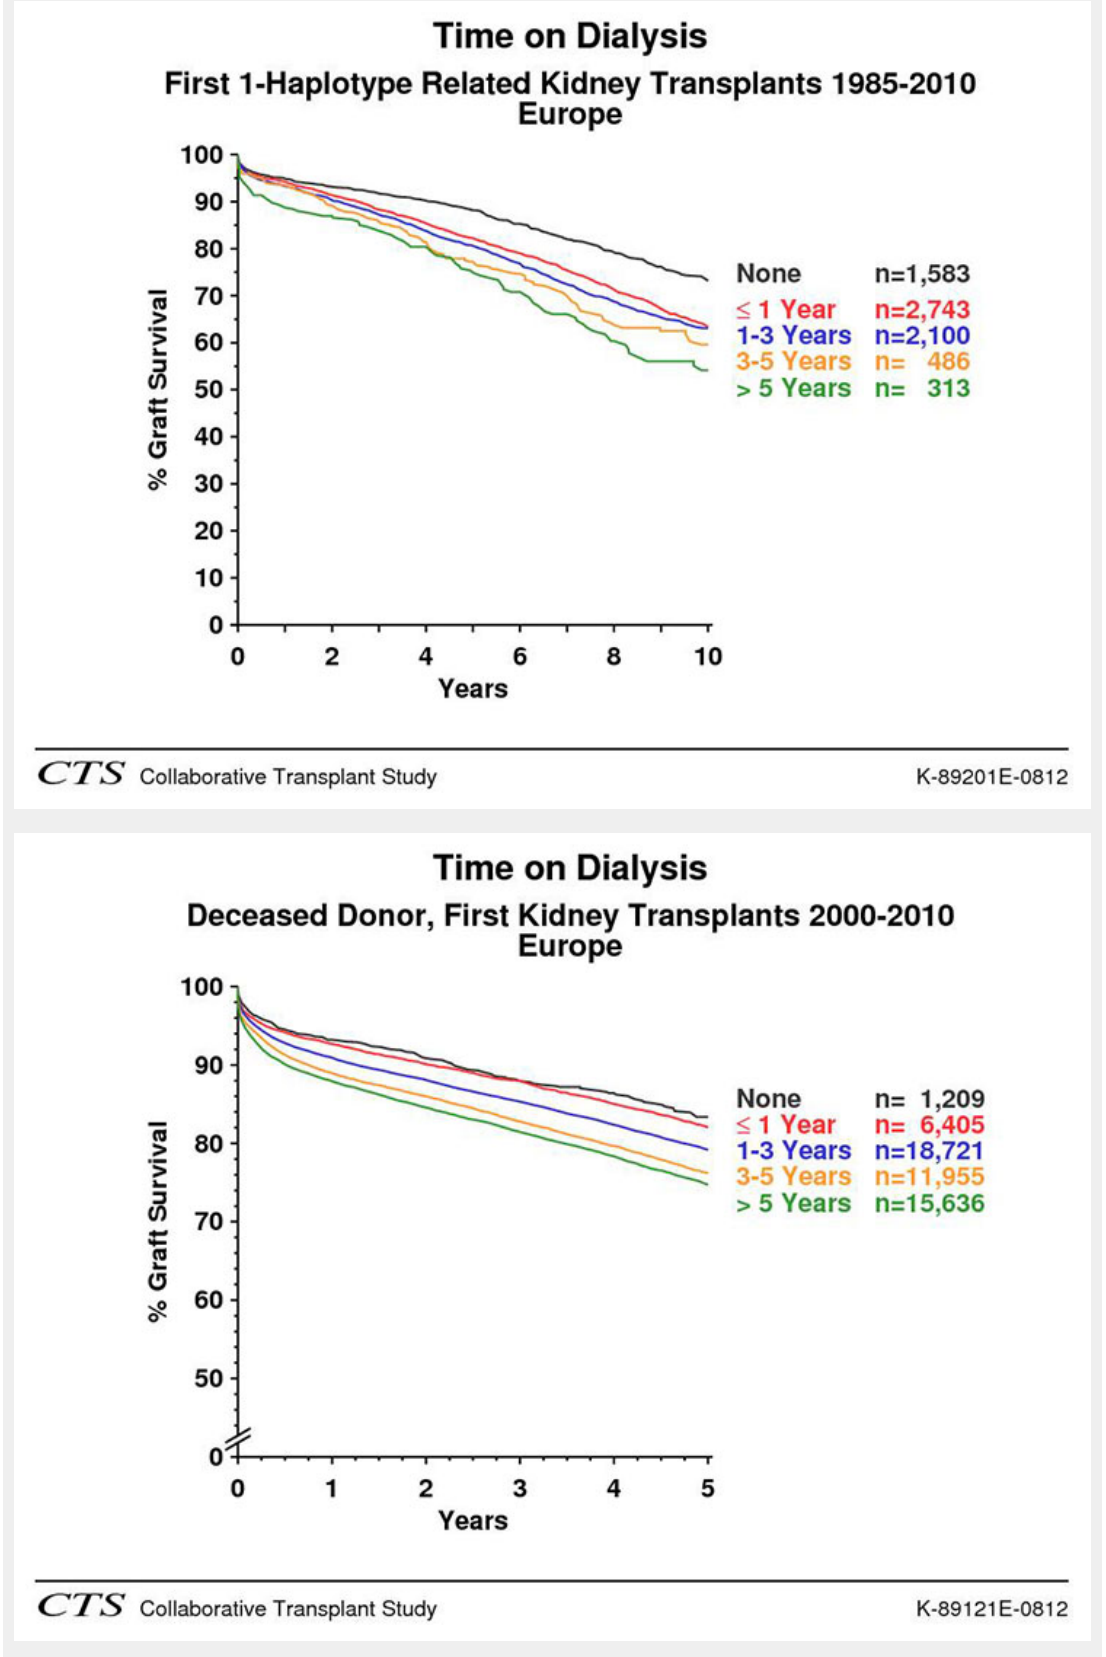
Figure 5 Impact of time on dialysis on graft survival after living donated (left panel) and deceased donor (right panel) kidney transplantation (CTS K-89201-0212 and K-89121-0212). (Source: http://www.ctstransplant.org, with kind